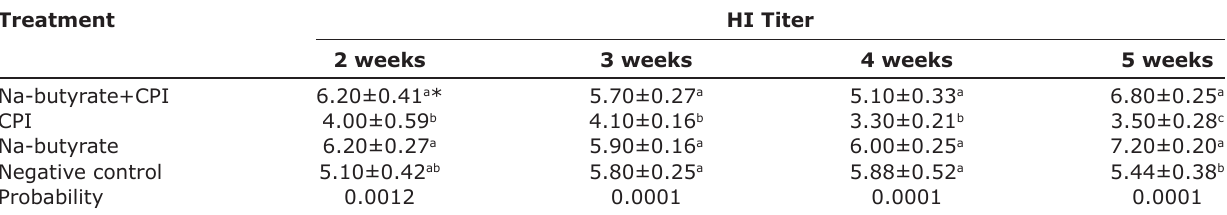
Table-5: Effect of Na-butyrate feed supplementation on weekly antibody titers against Newcastle virus vaccine of CPI and non-infected broilers.